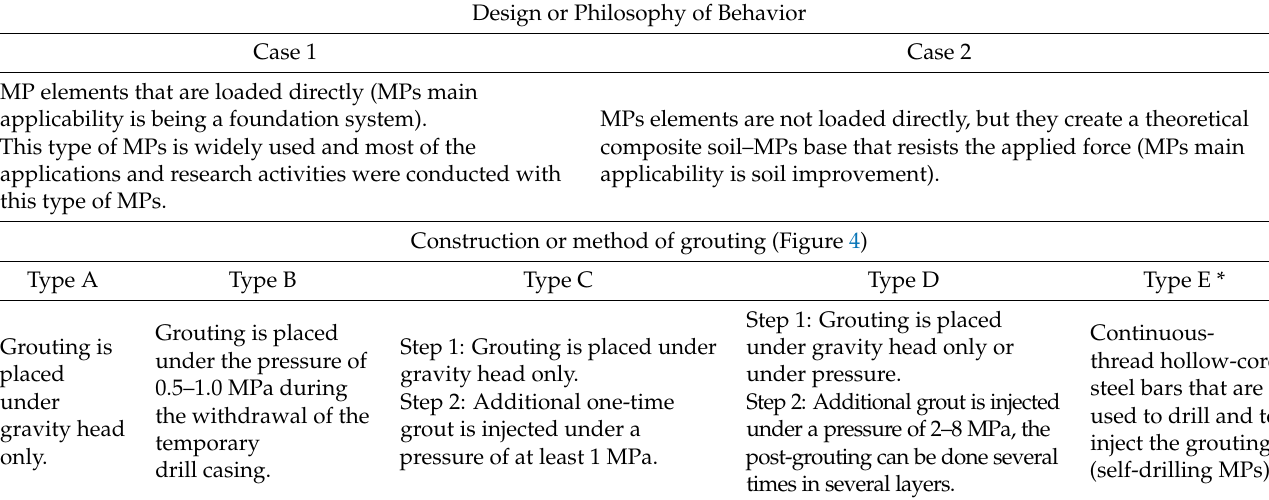
Table 1. Classification system of MPs after FHWA